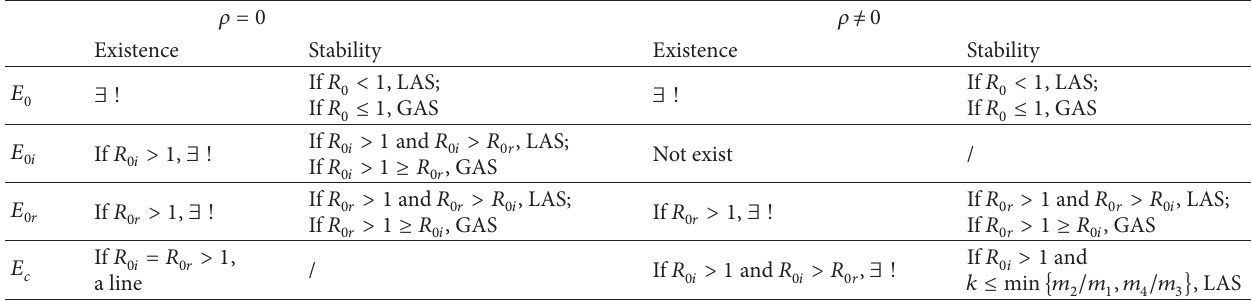
Table 1: Existence and stability of equilibria. The sign “ ∃ ! ” means the existence and uniqueness. LAS means locally asymptotically stable, and GAS means globally asymptotically